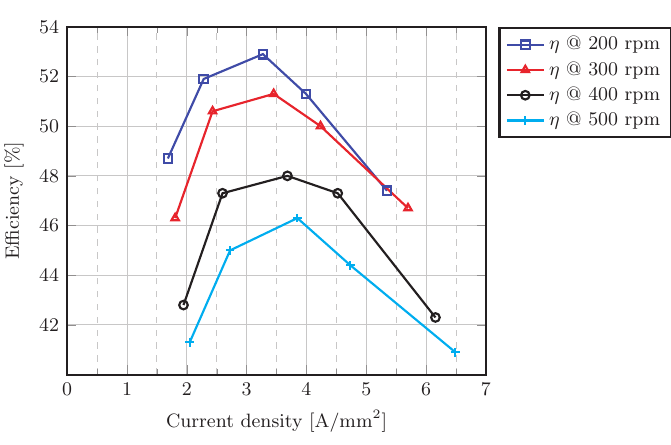
Figure 30. Efficiency vs. current at various speeds.